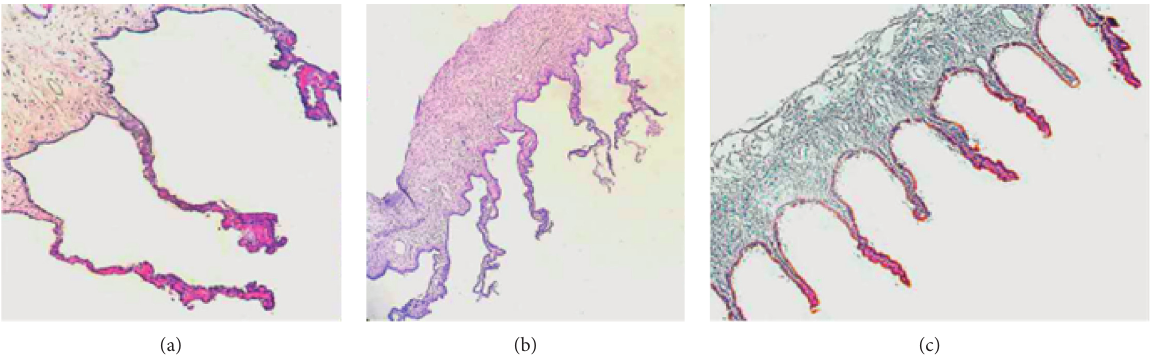
Figure 2: The difference among the UCP postoperative (a), cyclocryotherapy postoperative (b), and normal ciliary body (c). Magnification, × 40.